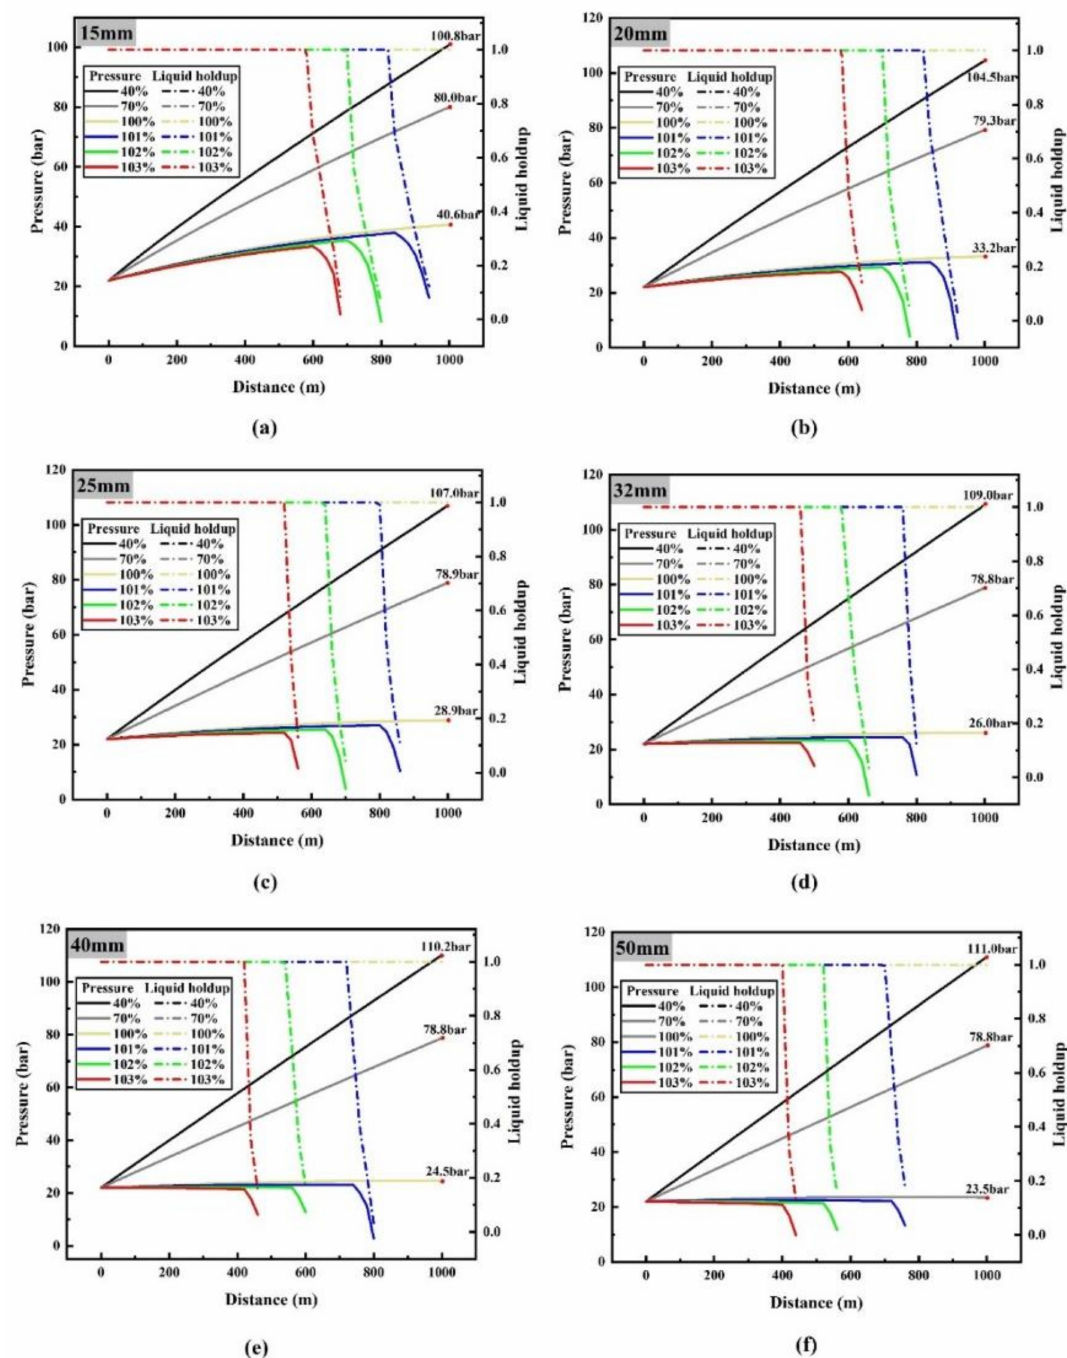
Figure 4. Curves of CO 2 pressure (solid line) and liquid holdup (dotted line) with depth at di ff erent flow rates under di ff erent pipe diameters: ( a ) 15 mm diameter; ( b ) 20 mm diameter; ( c ) 25 mm diameter; ( d ) 32 mm diameter; ( e ) 40 mm diameter; ( f ) 50 mm